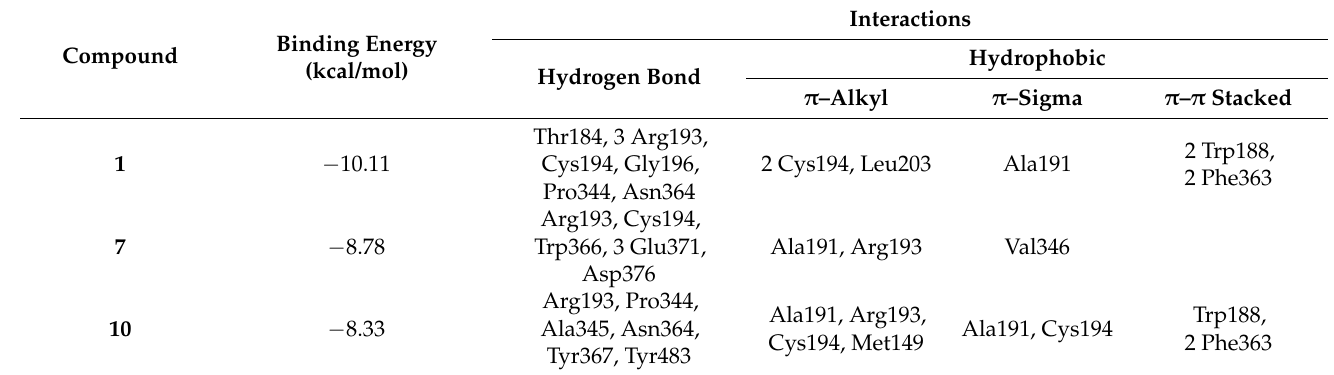
Table 3. Binding energy and intermolecular interactions of compound 1 , 7 , and 10 against iNOS